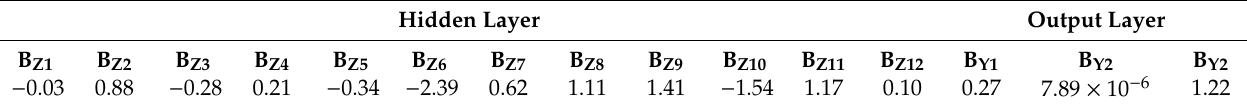
Table 12. Bias for hidden and output layer for intensity